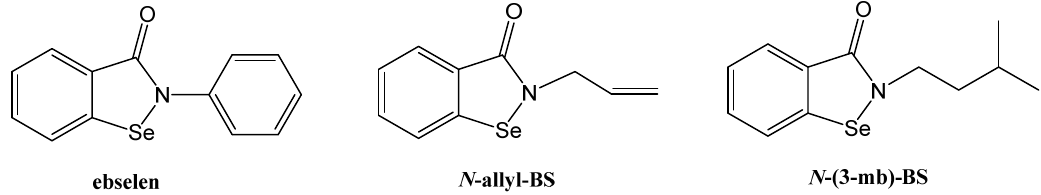
Figure 1. Molecular structure of ebselen, N -allyl-1,2-benzisoselenazol-3(2 H )-one ( N -allyl-BS), and N -(3-methylbutyl)-1,2-benzisoselenazol-3(2 H )-one ( N -(3-mb)-BS).